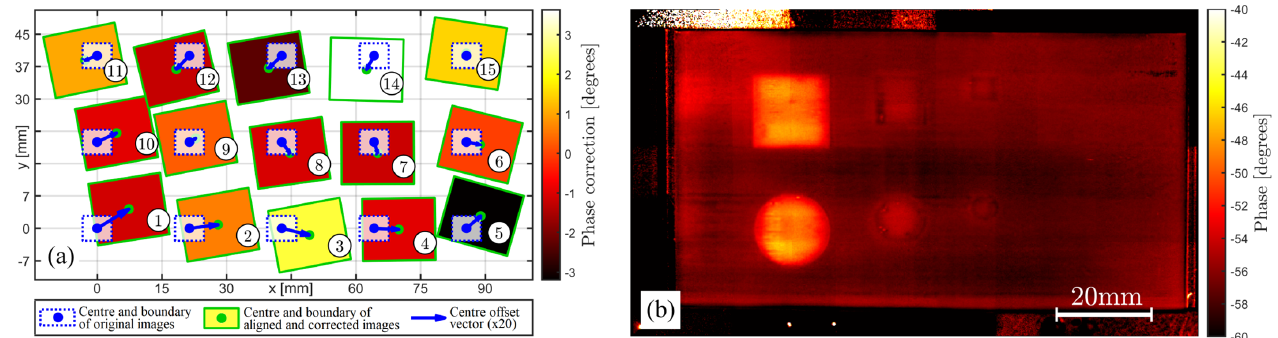
Figure 13. ( a ) Schematic illustration of similarity transformations and pixel intensity corrections computed through the proposed method for the set of images relative to the sample without the grid. ( b ) Resulting composite mosaic thermographic image.